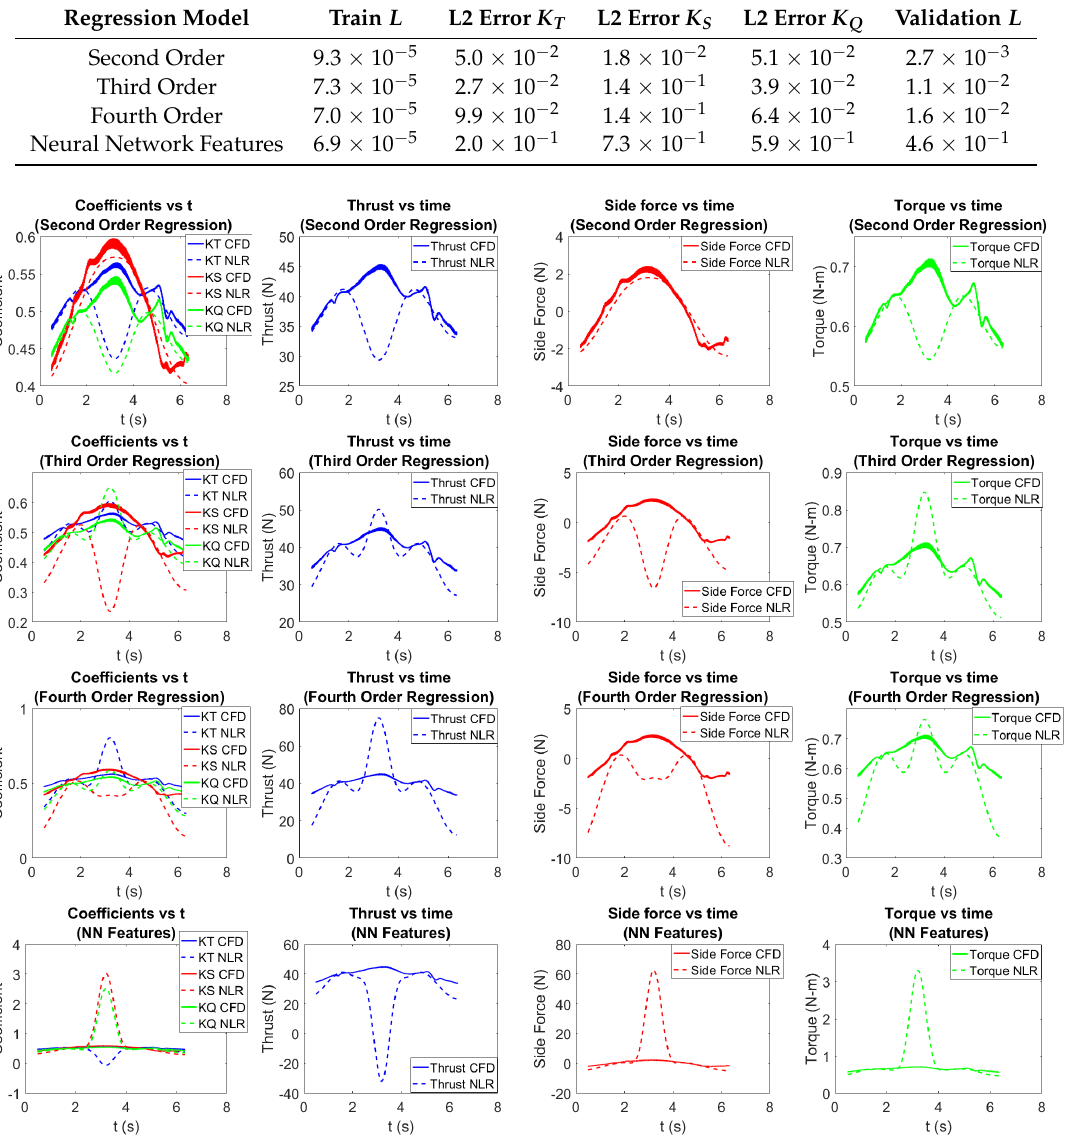
Figure 14. Coefficients, thrust, side force, and torque for behind condition nonlinear regression validation case. Top row: Lowest order regression. Bottom row: Highest order